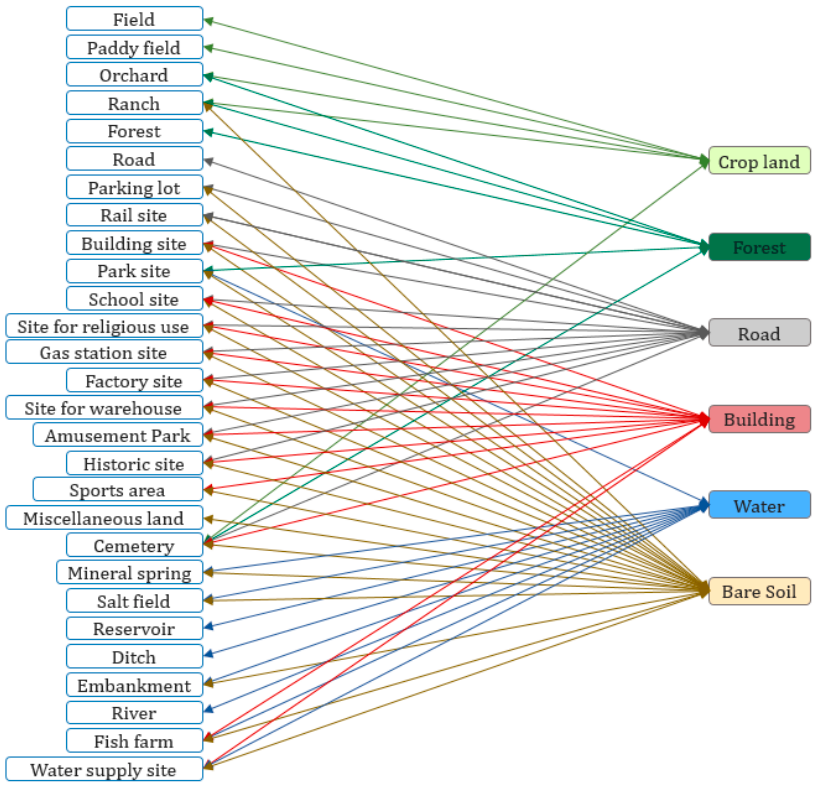
Figure 10. Mapping rule between land category and land cover.